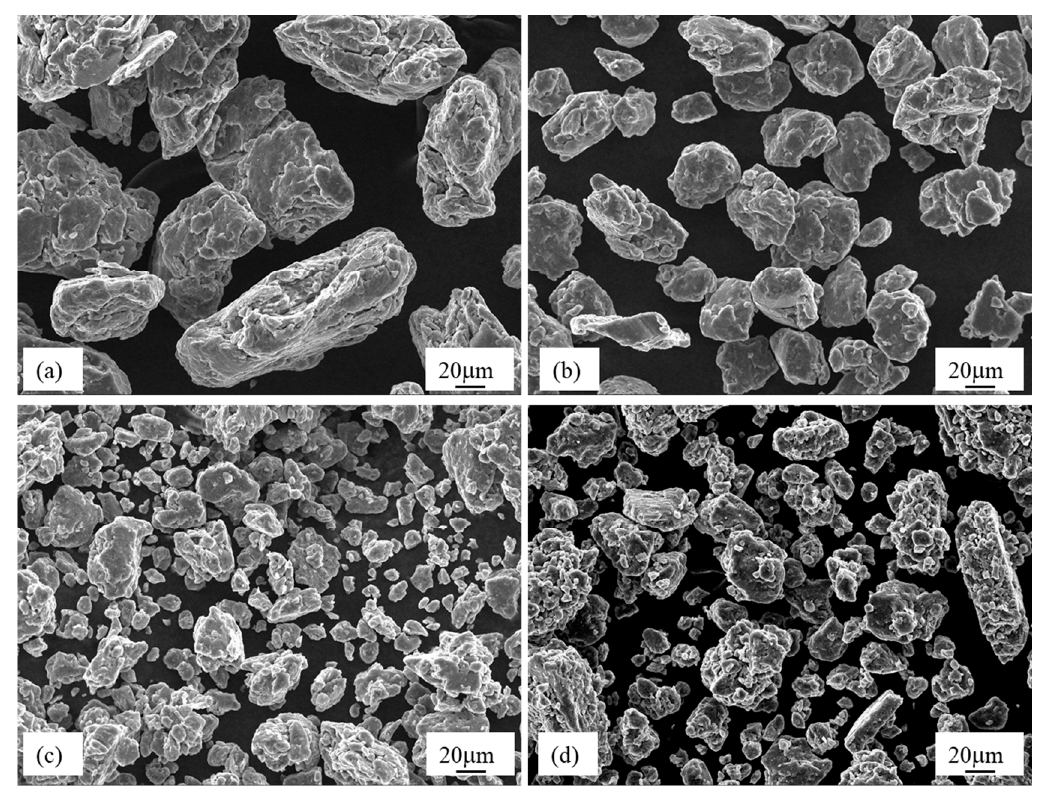
Figure 1. Morphology of powder mixture after mechanical alloying for ( a ) 1 h, ( b ) 10 h, ( c ) 20 h and ( d ) 30 h.